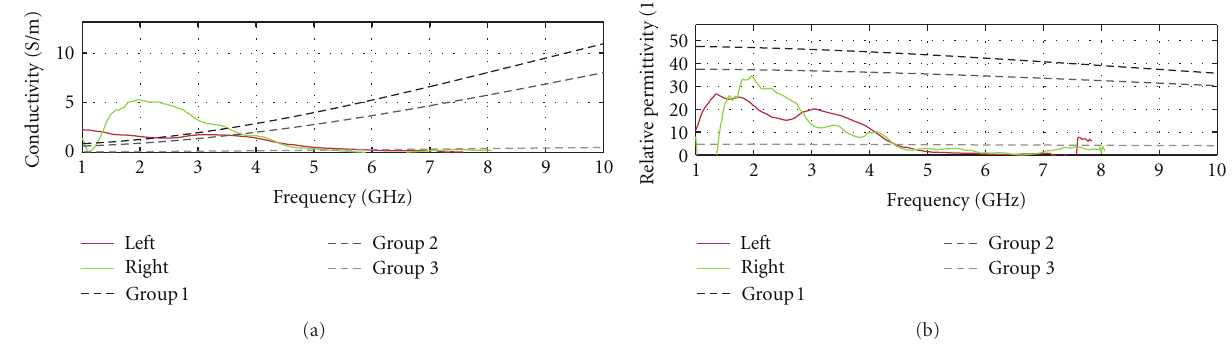
Figure 16: Estimation of breast tissues electrical properties (conductivity in (a) and permittivity in (b)) for the 30-year-old volunteer. Groups 1, 2, and 3 refer to the tissue categories defined in